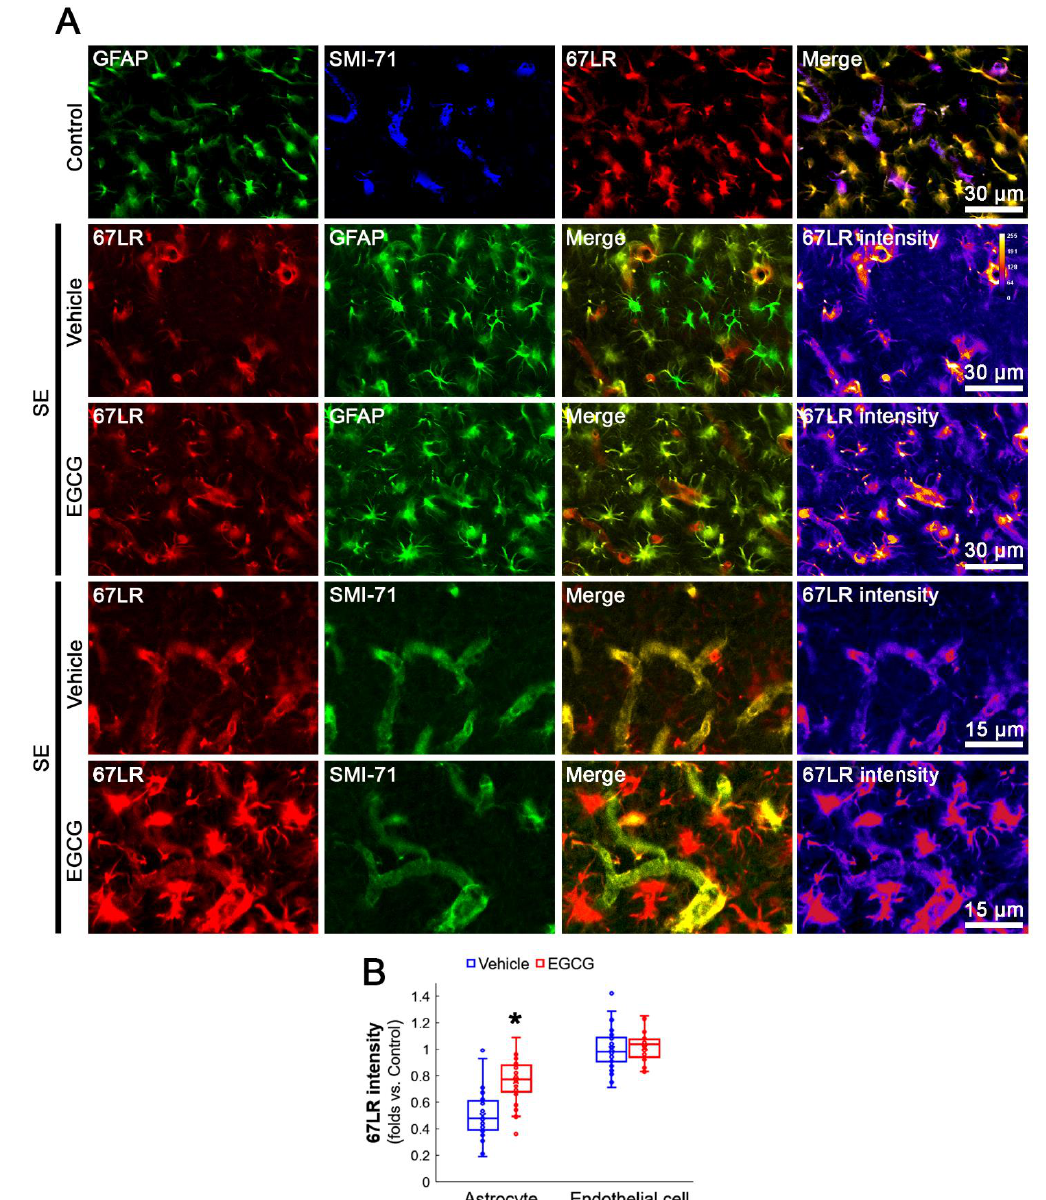
Figure 4. Effects of EGCG on 67LR expression in the FPC following SE. The 67LR expression is observed in astrocyte and endothelial cells in control animals. Following SE, 67LR expression is reduced in astrocytes, but not in endothelial cells, which is attenuated by EGCG. ( A ) Representative photos of GFAP, SMI-71 and 67LR in the FPC. ( B ) Quantification of 67LR intensity in astrocyte and endothelial cells. * p < 0.05 vs. vehicle ( n = 40 cells in 7 rats, respectively).